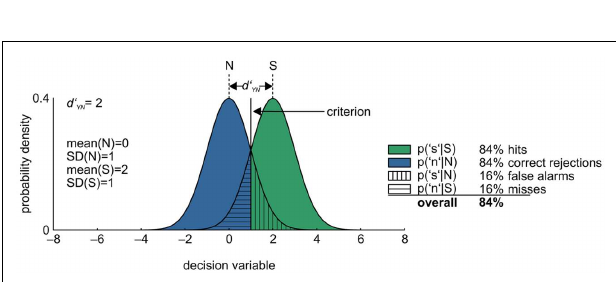
√ ∗ d (cid:2) YN √ ∗ = d (cid:2) ) is 2 2. Translated FC YN 2 = 1. YN